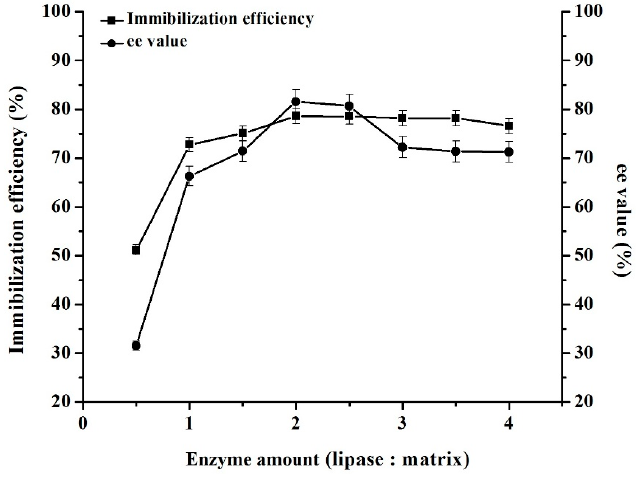
Figure 3. Effects of enzyme amount (lipase: matrix) on the immobilization efficiency and ee value in the solution pH of 7. (Reaction conditions: 0.02 g immobilized lipase as catalyst, 45 °C, 1 h).